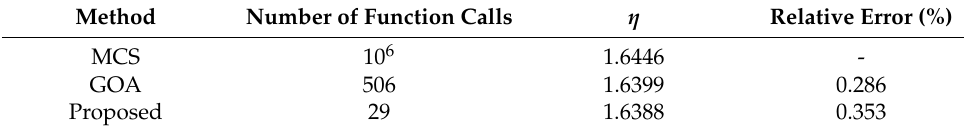
Table 4. Result comparison using different methods for Example